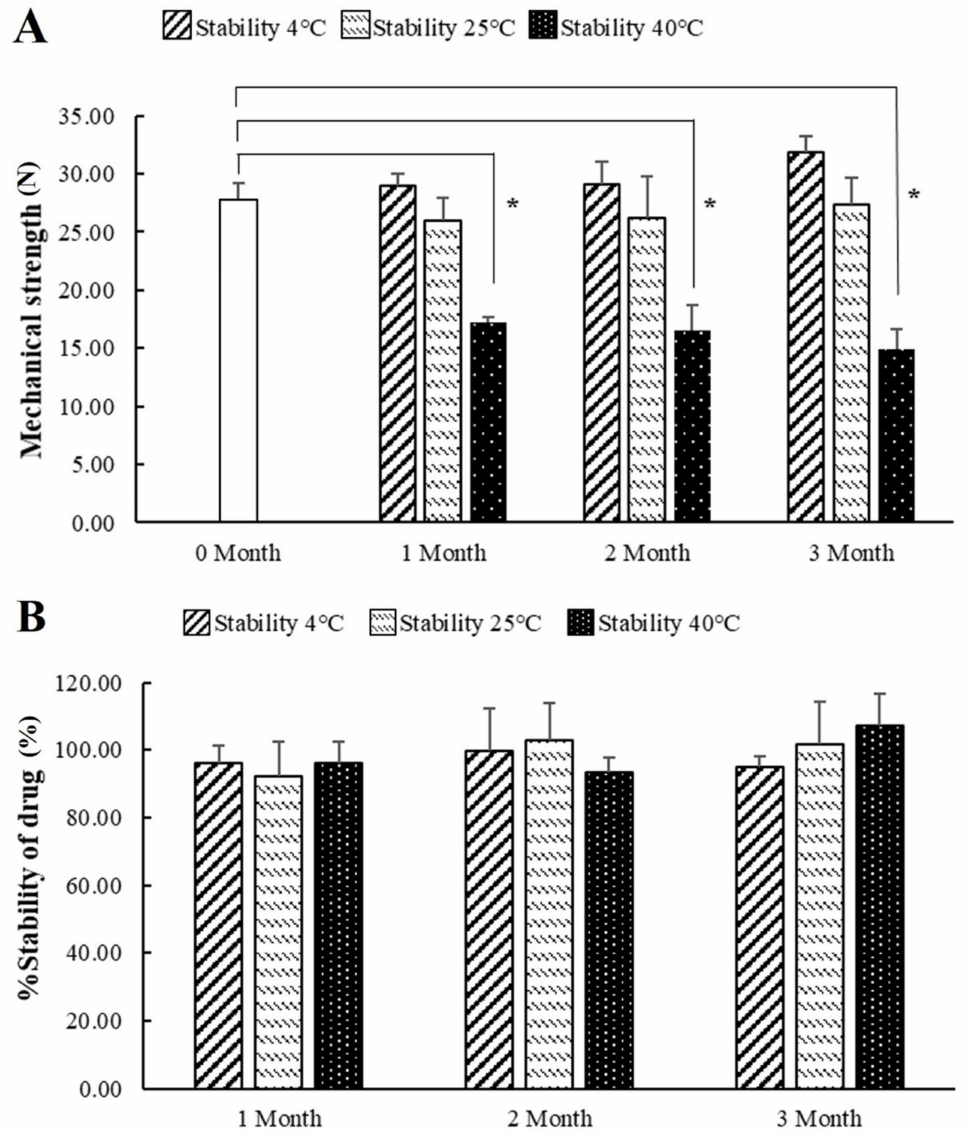
Figure 12. Stability of FLUZ-MEs-loaded two-layered MNs at 4 ◦ C, 25 ◦ C, and 40 ◦ C for 0, 1, 2, and 3 months. ( A ) The mechanical strength and ( B ) % of stability of the drug. All data are represented in means ± SD with triplicate trials. * indicates significantly lower than 0 month ( p <